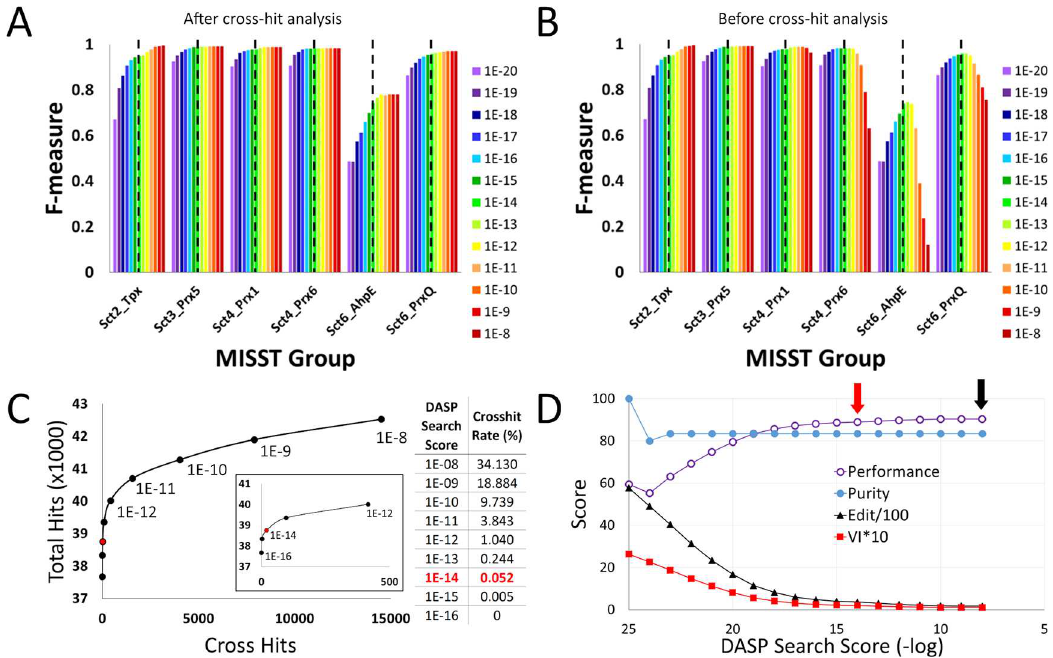
Fig 6. Quantitative analysis shows final MISST groups are distinct and correspond well with previously identified proteins. F-measure,the harmonic mean of precisionandrecall, is calculatedfor each of the six MISST groups at each DASP2 search score threshold(A, B). DASP2 score thresholdsare representedby different coloredbars, according to the legend,from most significant (purple)to least significant(red); dashed black lines indicatethe significance threshold (cid:20) 1e- 14. F-measure was calculatedboth before executing cross hit analysis(B) andafter executing cross hit analysis(A) (see Methods). The numberof cross hits, or GIs identifiedby more than one MISST group, is plotted againstthe numberof uniqueGIs identifiedby all six MISST groups at each DASP2 search score threshold (C). The inset is a magnifiedview, showingonly thresholds (cid:20) 1e-12to (cid:20) 1e-16.A table shows the cross hit rate as a percentage, which is the numberof cross hits dividedby the number of total uniquehits, at each score threshold. In both the graph and the table, the significance threshold (cid:20) 1e-14is highlightedin red. The graphsand table in both (B) and (C) were constructed prior to completing cross hit analysis(see Methods). Performance, edit distance, VI distanceand purity values(detailsin S3 File) are shownfor each DASP2 search score thresholdfrom (cid:20) 1e-8 to (cid:20) 1e-25(D). These scores were calculatedafter executingcross hit analysis. The blackarrow highlightspeak performance and the red arrow highlights the significance threshold (cid:20)